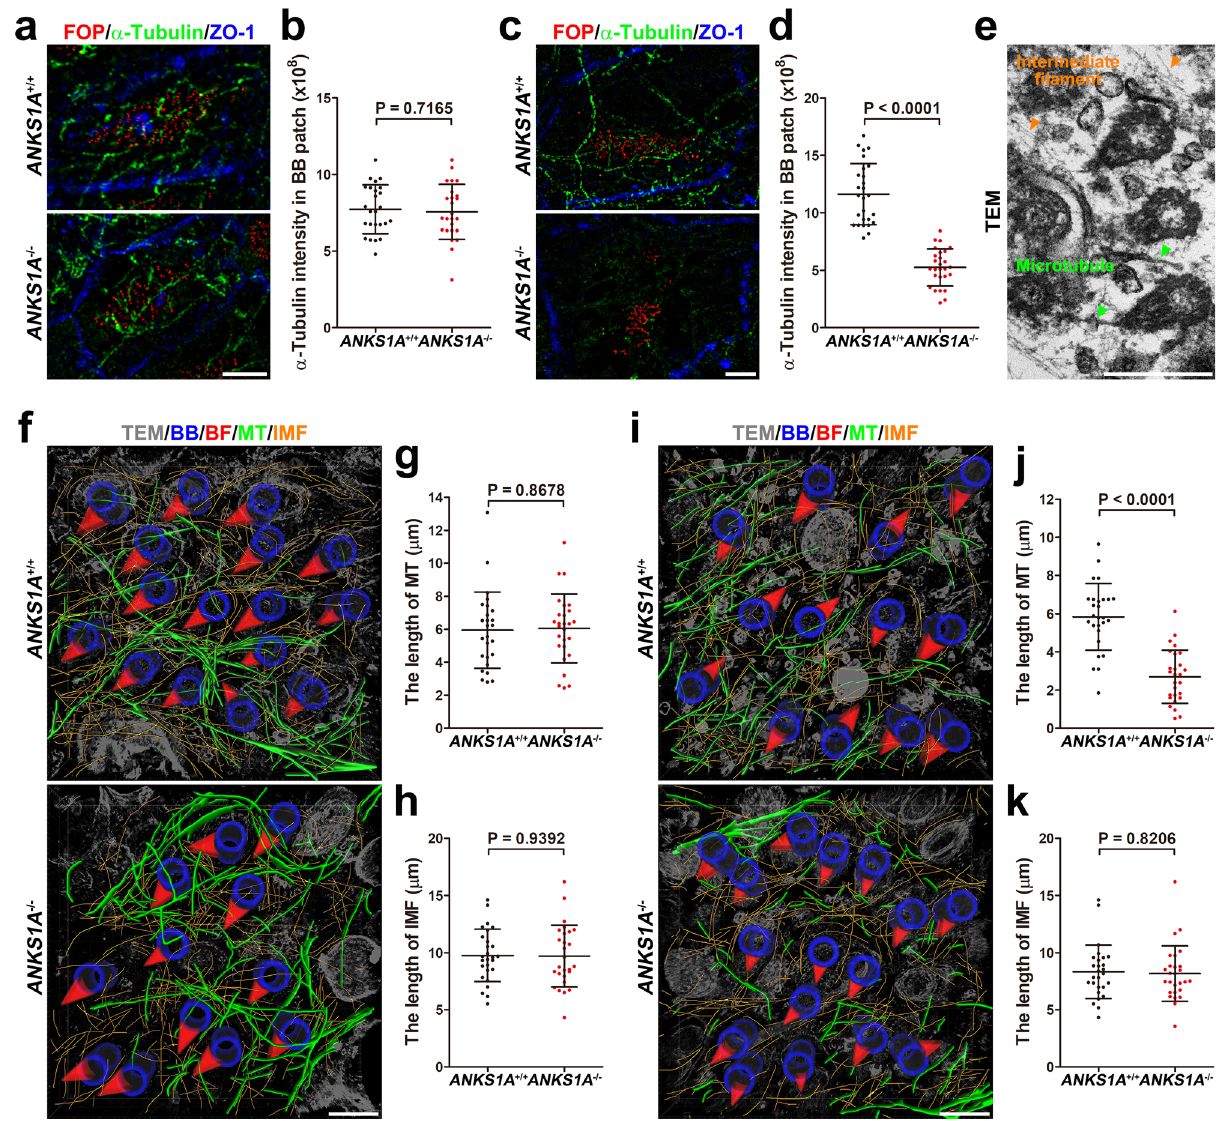
Fig. 7 ANKS1A de fi ciency results in a marked loss of the microtubule network in aged mice. a – d 3DSIM images of the MT networks stained with alpha- tubulin antibody for both young (P45) and aged (20-month old) mice. a , b ANKS1A + / + set, n = 6 cells from 2 mice; ANKS1A − / − , n = 5 cells from 2 mice. c , d ANKS1A + / + set, n = 9 cells from 3 mice; ANKS1A − / − , n = 9 cells from 3 mice. Scale bar for a , c , 5 μ m. e A representative TEM image illustrating the intermediate fi lament and microtubule. Scale bar, 500 nm. f – j 3D reconstruction of the microtubule and intermediate lattice. The image of the microtubules (green) and intermediate fi lament (orange) was reconstructed and superimposed on a single plane. For g , h (P45 mice), ANKS1A + / + set, n = 10 cells from 2 mice; ANKS1A − / − , n = 10 cells from 2 mice. For j , k (20-month-old mice), ANKS1A + / + set, n = 9 cells from 2 mice; ANKS1A − / − , n = 9 cells from 2 mice. Scale bar for f , i , 500